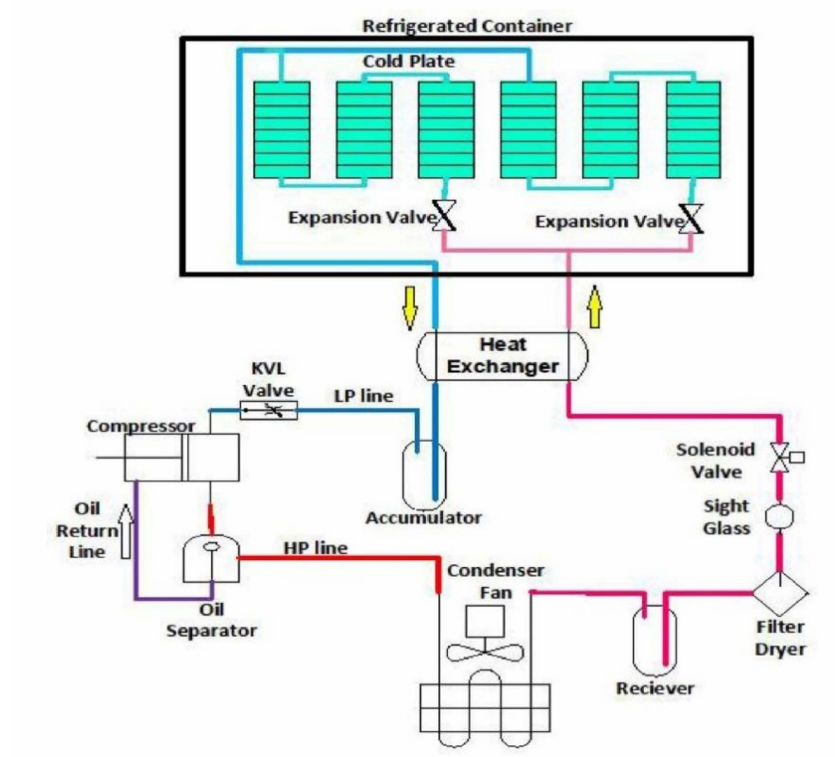
Figure 8. The schematic diagram of the hybrid refrigeration system (VCRS+PCM). Reprinted from ref. [45], Copyright (2020), with permission from